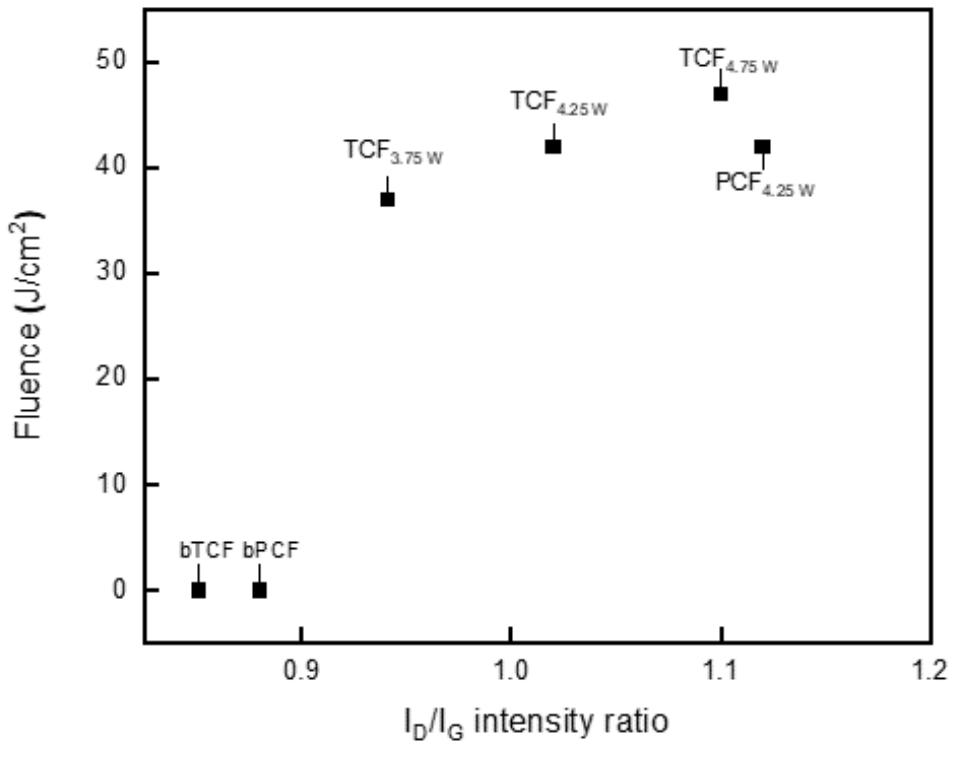
Figure 8. Fluence vs I D /I G intensity ratio of the irradiated samples.